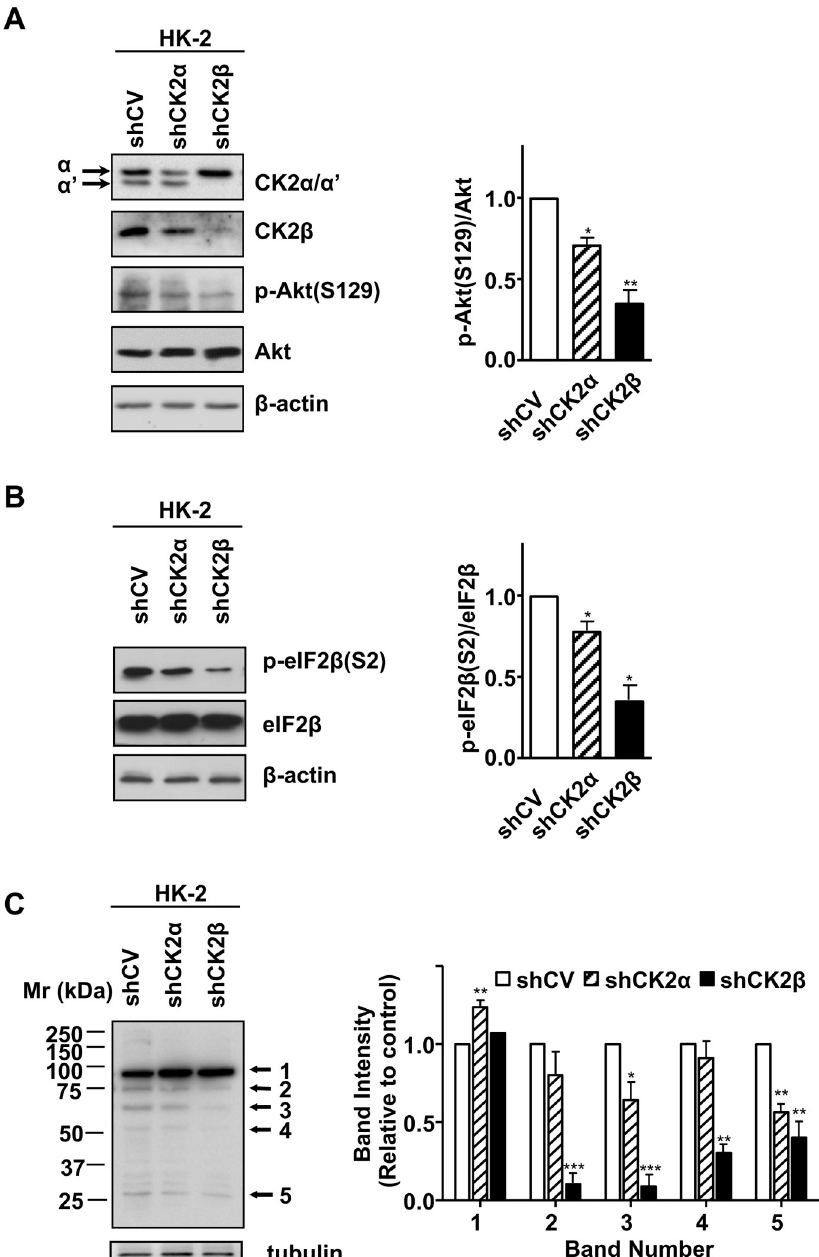
Fig 1. CK2 expression and activity in response to CK2 α and CK2 β downregulation in HK-2 cells. (A) HK-2 control (shCV) and silenced cells (shCK2 α and shCK2 β ) were analysed for the expression of each CK2 subunit ( α , α ’ or β ) and for the phosphorylation state of the CK2 target Akt S129. The 1AD9 anti-CK2 α antibody detects also CK2 α ’; the arrows indicate the migration of each catalytic isoform. (B) Detection of total and phosphorylated eIF2 β (S2) using specific antibodies. β -actin was used as a loading control. (C) The phosphorylation of endogenous CK2 substrates were analysed in lysates of HK-2 control (shCV) and silenced cells (shCK2 α and shCK2 β ) by Western blot using Phospho- (Ser/Thr) CK2 Substrate (P-S/T3-100) antibody. Arrows indicate the bands that are more affected by CK2 β down- regulation, whose quantification is shown in the bar graph. Tubulin was used as a loading control. A representative Western blot is shown in each case, while quantification (means ± SEM) is shown in the bar graphs. n = 4 for panel (A) and (B), n = 3 for panel (C).